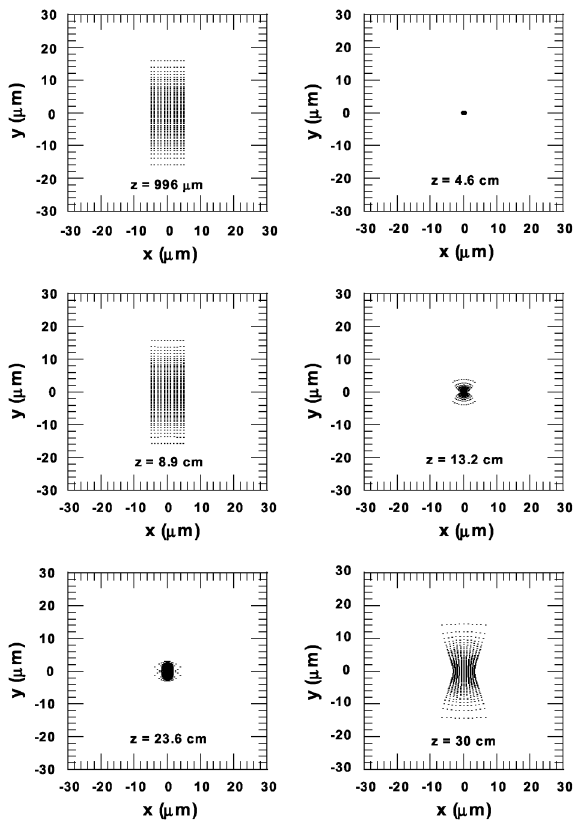
FIG. 19. Acceleration test particle distributions on the x - y planes at z (cid:3) 996 (cid:4) m (initial), 4.6 cm (focusing), 8.9 cm (defocusing), 13.2 cm (focusing), 23.6 cm (focusing), and 30 cm (final). 891 electrons initially distributed uniformly in the x direction and Gaussianly in the y direction within a rectangle of j x j (cid:12) 5 (cid:4) m and j y j (cid:12) 15 : 9 (cid:4) m experience focus- ing and defocusing alternatively, and finally all the particles reach the end of z (cid:3) 30 cm without hitting any walls.